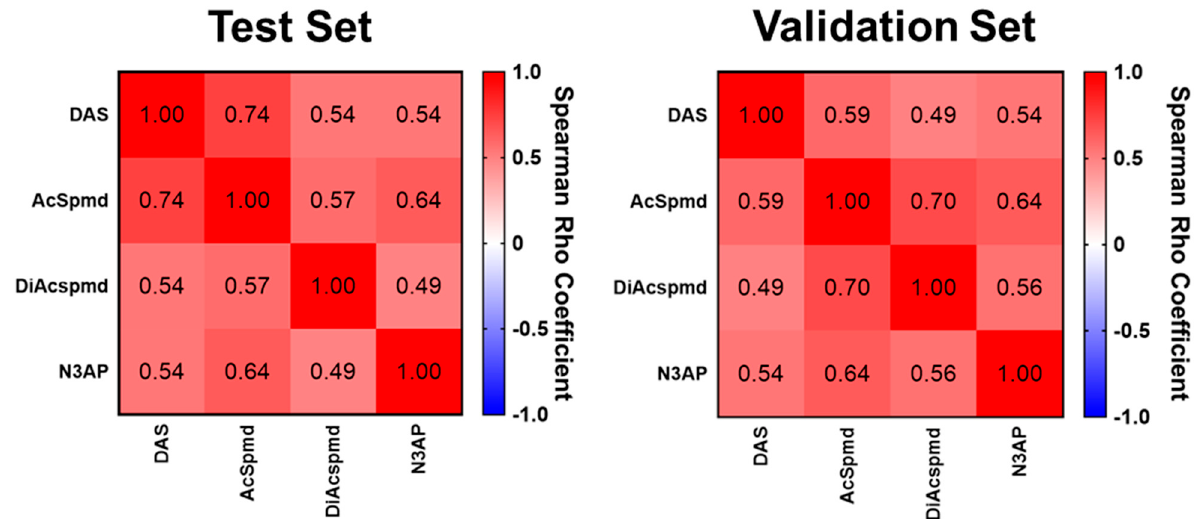
Figure A1. Spearman correlation matrix for polyamines. Heatmaps depicting spearman correlation coefficients amongst the 4 measured polyamines in the Test Set (left panel) and Validation Set (right panel). Embedded values represent Spearman correlation coefficients. All cases and controls corresponding to the respective test set were included in the analyses. Abbrev. DAS- diacetylspermine; AcSpmd- acetylspermidine; DiAcspmd- diacetylspermidine; N3AP- N-(3- acetamidopropyl)pyrrolidin-2-one.